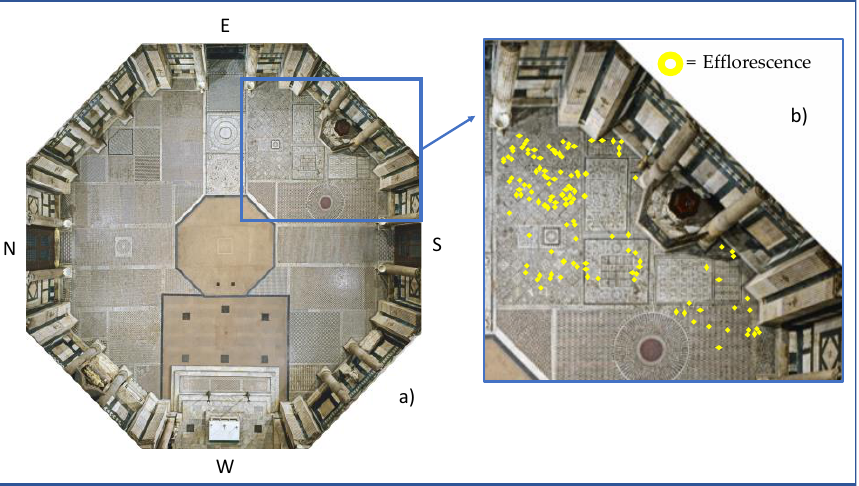
Figure 2 . ( a ) The pavement of the San Giovanni baptistery [14]; ( b ) The efflorescence map of the studied pavement area.